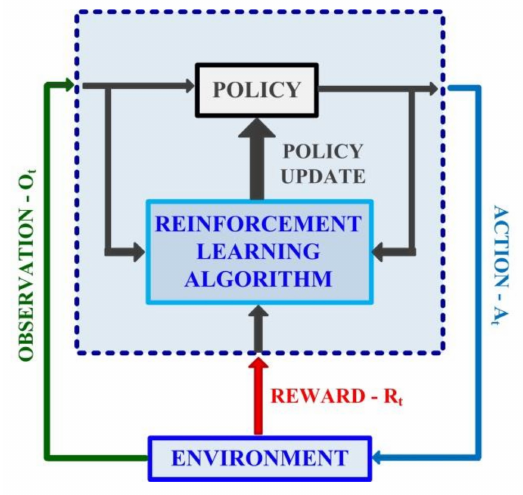
Figure 1. Schematic diagram for a RL